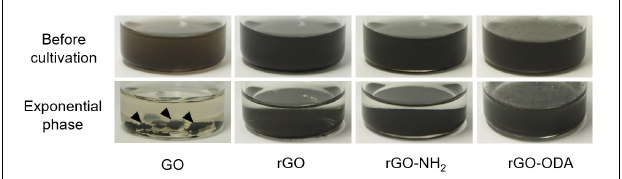
FIGURE 2 | The appearance of coculture bottles containing different GO-based materials before cultivation and at the exponential phase. Arrowheads indicate self-aggregated